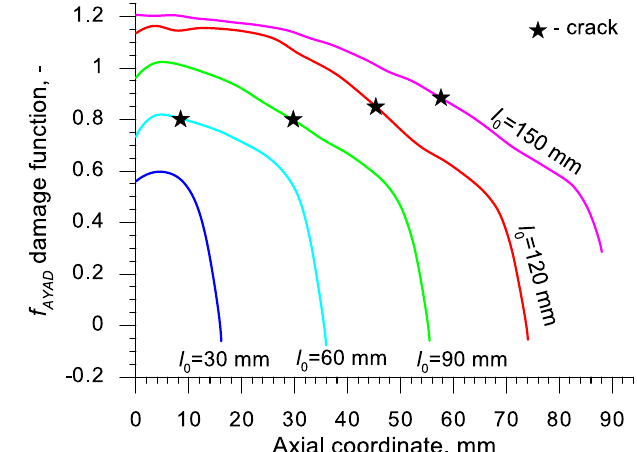
Figure 24. Distributions of the damage function in the axis of a rotationally compressed sample, determined on the basis of the Oh et al. criterion.